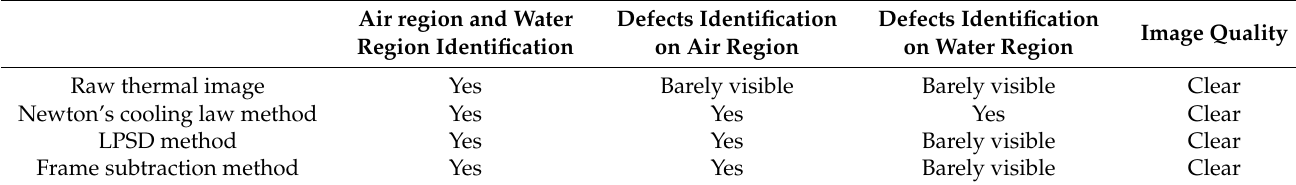
Table 7. Summary of merits and demerits of each method in Case 1.